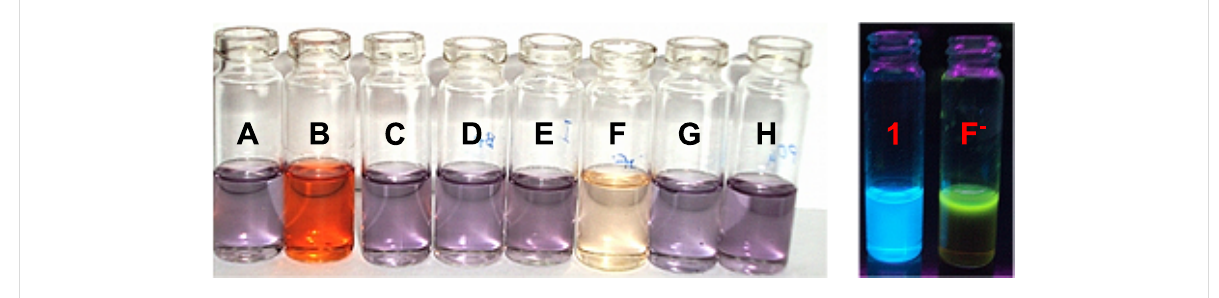
Figure 3: Color changes of receptor 1 (A) ( c = 1.1 × 10 −4 M) in CH 3 CN/H 2 O (4:1 v/v) on addition of tetrabutylammonium salt (TBAX), X = F − (B), Cl − (C), Br − (D), I − (E), AcO − (F), HSO 4− (G), and H 2 PO 4− (H) (left side); green fluorescence observed on addition of F − ion to receptor 1 (right side).